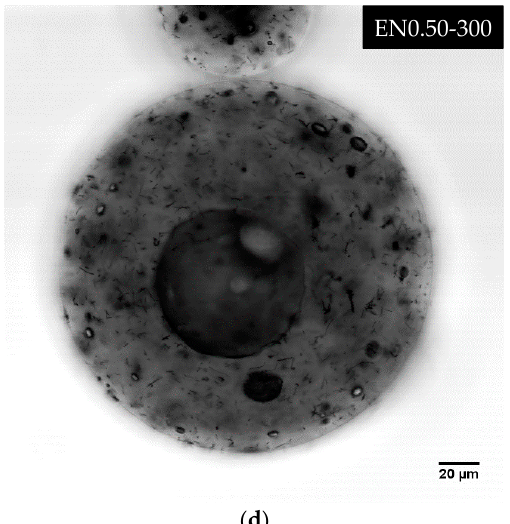
Figure 13. Laser scanning confocal microscopy (LSCM) micrographs showing morphological features observed within the microcapsules.